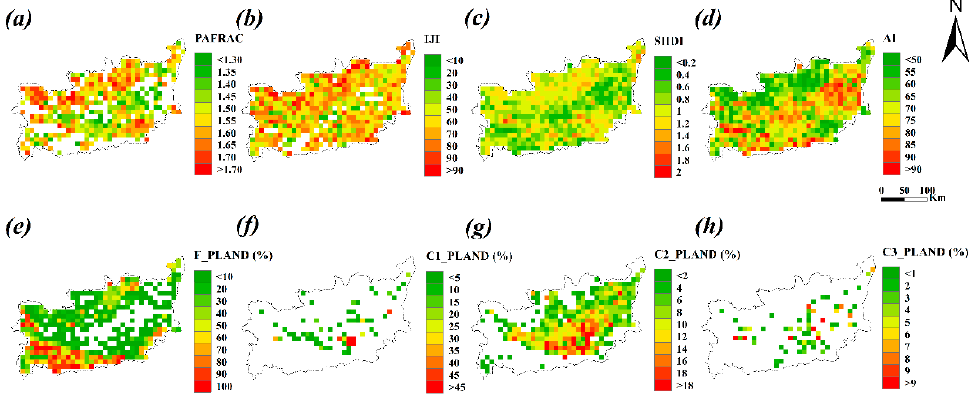
Figure 8. Landscape patterns of ( a ) PAFRAC; ( b ) IJI; ( c ) SHDI; ( d ) AI; ( e ) F_PLAND; ( f ) C1_PLAND; ( g ) C2_PLAND; and ( h ) C3_PLAND in the Guanzhong urban agglomeration.